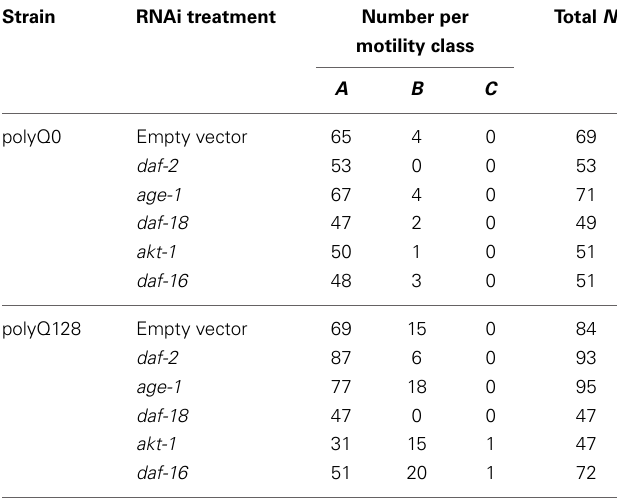
Table 1 | Effect of RNAi treatment on polyQ0 and polyQ128 motility. Strain RNAi